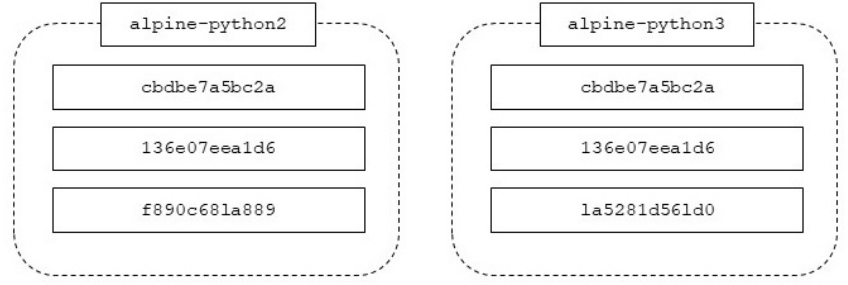
Figure 5. Independent Image Download